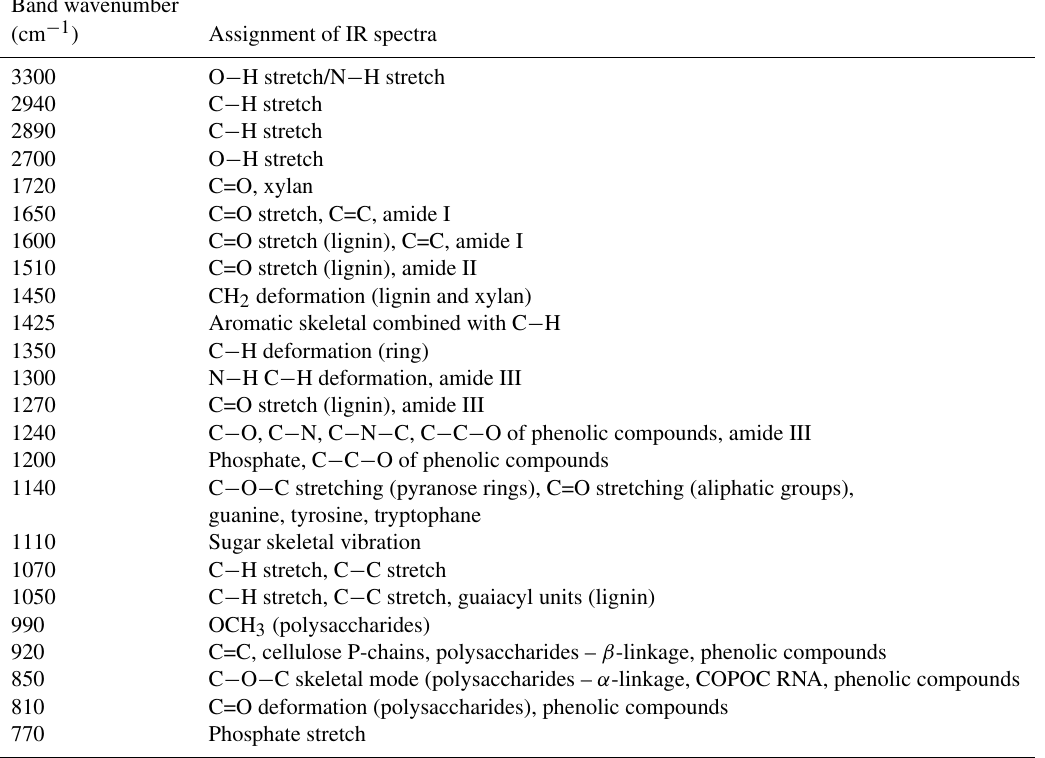
Table 3. Band assignment of the IR spectra of TBA extracts (leaves, primary wood, and secondary wood) and birch pollen washing water (Miyazawa et al., 1956; Kaˇcuráková et al., 2000; Schulz and Baranska, 2007; Chen et al., 2010; Pummer et al.,